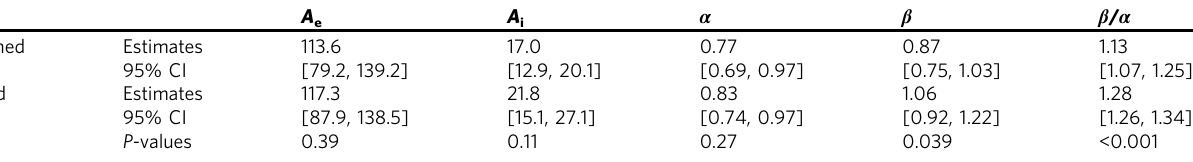
Table 3 Model parameters, comparing post-training results for untrained and trained motion directions